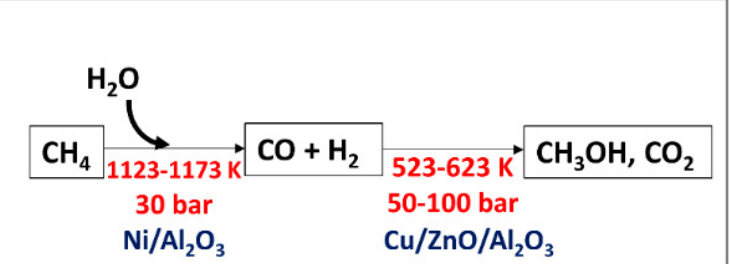
Figure 6. Indirect process of methanol production (Sharma et al., 2020). Reproduced with permis- permission from Sharma et al. Copyright © 2022, MDPI. sion from Sharma et al. Copyright © 2022, MDPI.